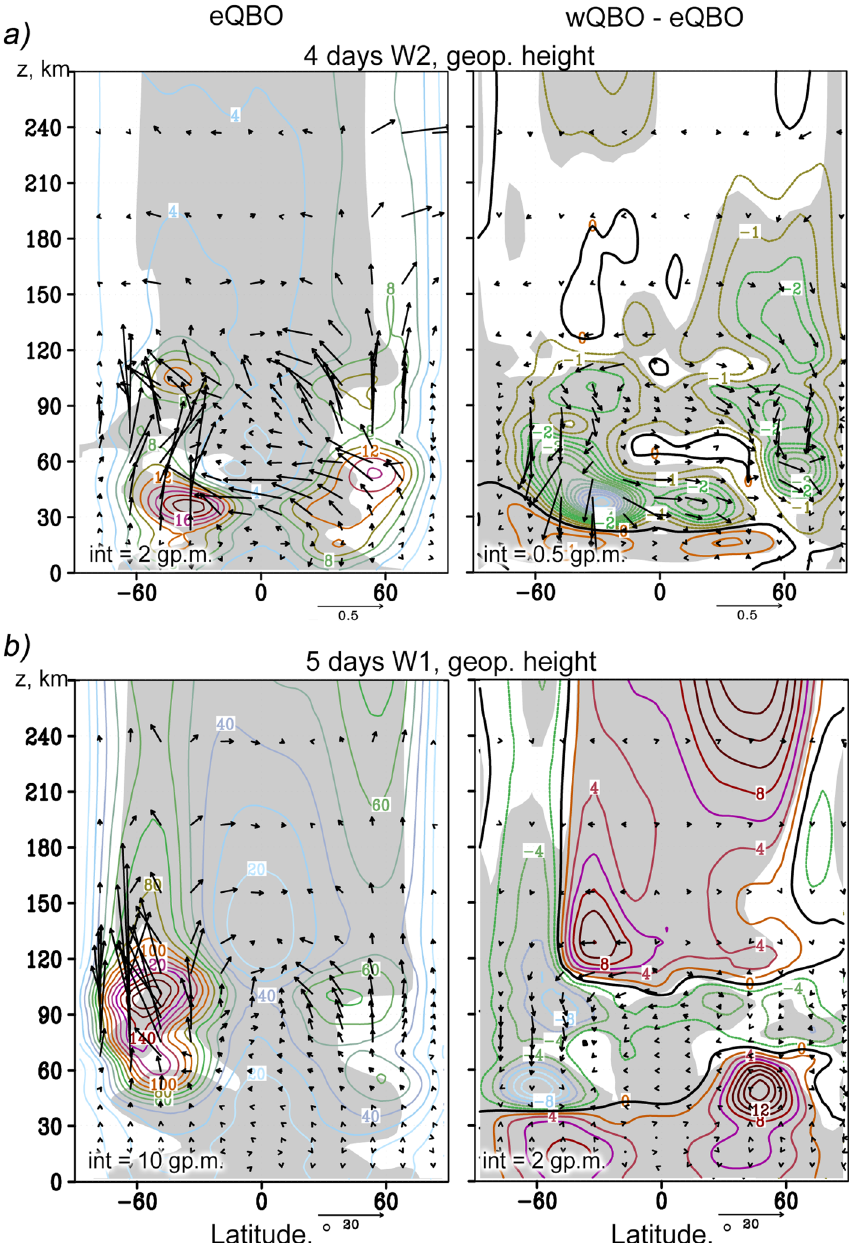
Figure 3. The same as Fig. 2 but for the westward travelling atmospheric NMs: τ = 4 days, m = 2 ( a ); τ = 5 days , m = 1 ( b